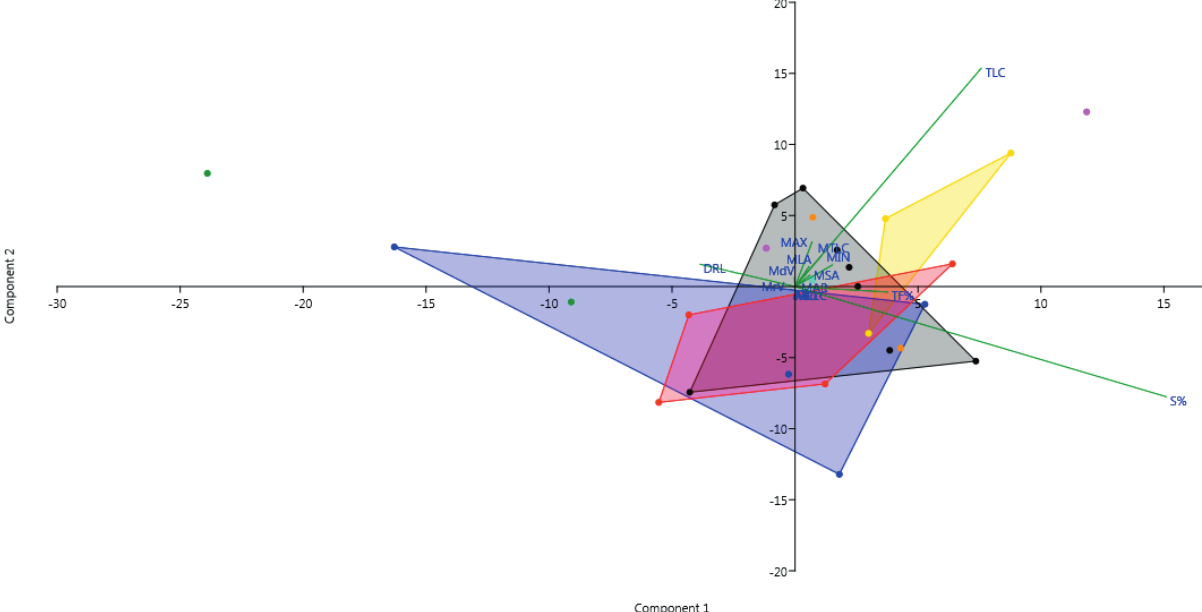
Figure 5. PCA scatter plot diagram (Different colors refer to different sections and the lines with variables indicate the effect and direction of